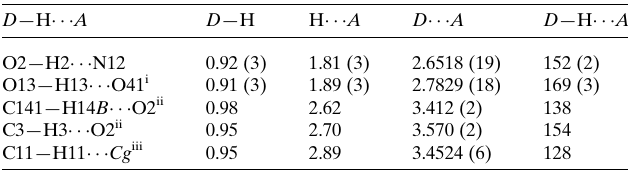
Table 3 Hydrogen-bond geometry (A˚ , (cid:2) ) for 3 . Cg is the centroid of the C1–C6 ring.